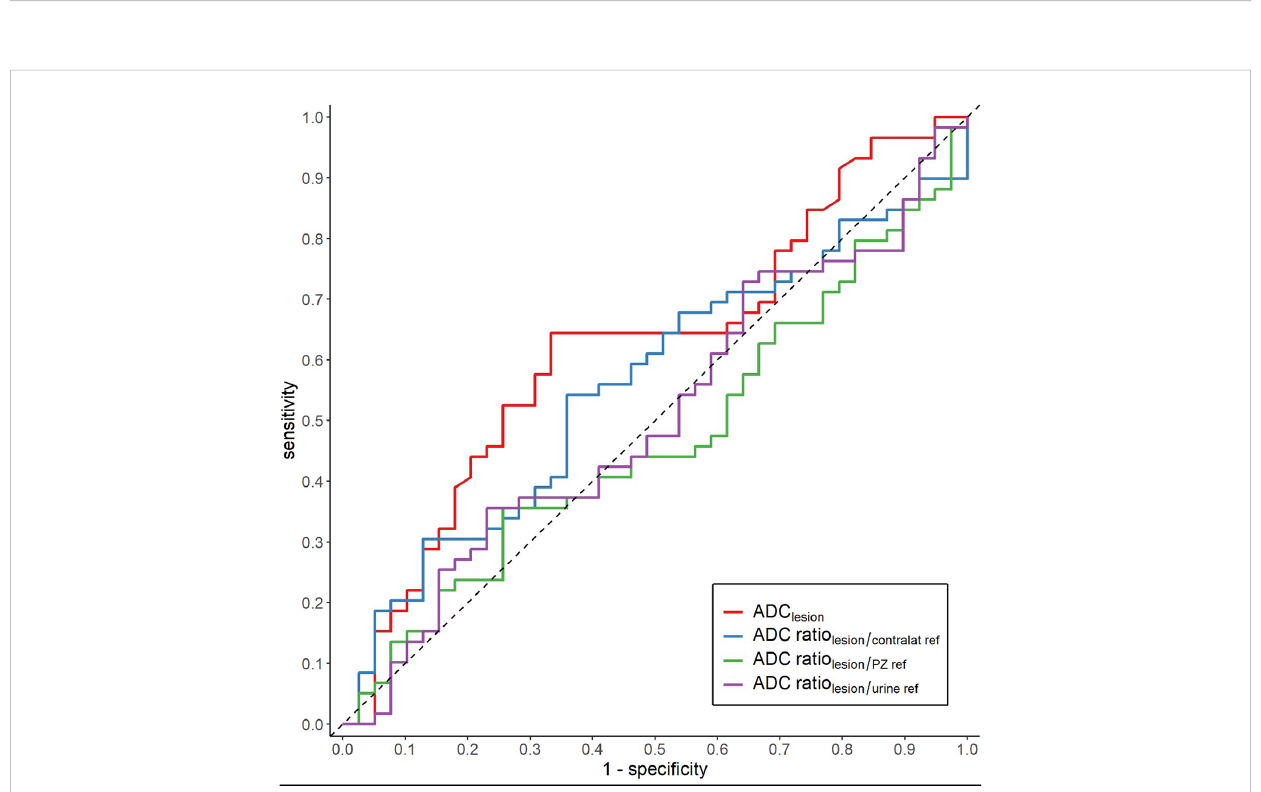
FIGURE 4 ROC curves comparing absolute ADC and three different ADC ratios in discriminating ISUP 1-2 from ISUP